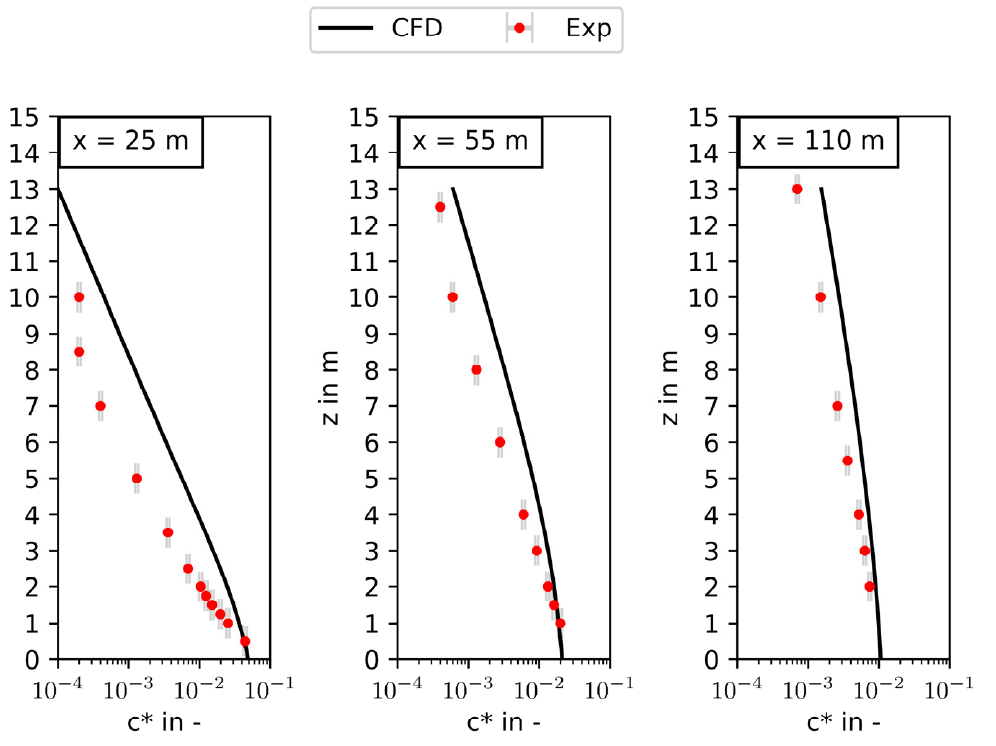
Figure 7. Vertical concentration profiles on the neutrally buoyant gas cloud centerline in 25 m ( left ), 55 m ( middle ) and 110 m ( right ) to the origin, and 5 m, 35 m and 90 m to the source, respectively.